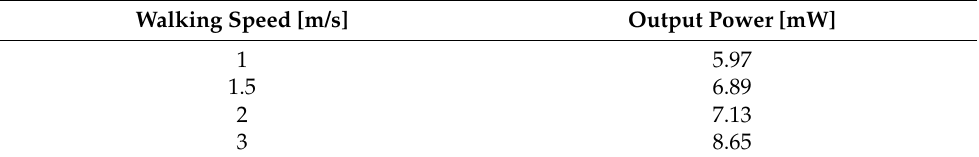
Table 6. Power values provided by piezoelectric harvesting section for different walking